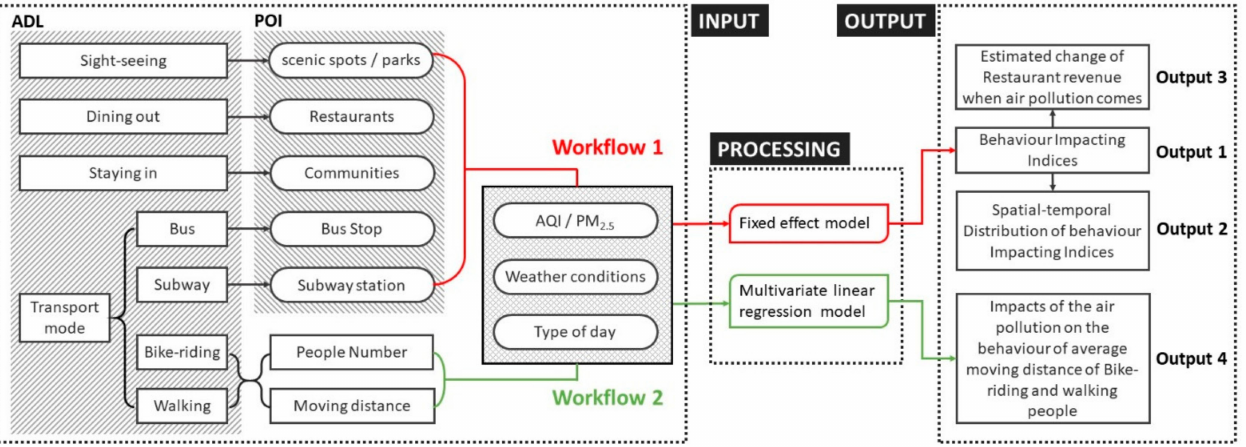
Figure 2. Overview of the methodology for the IoB